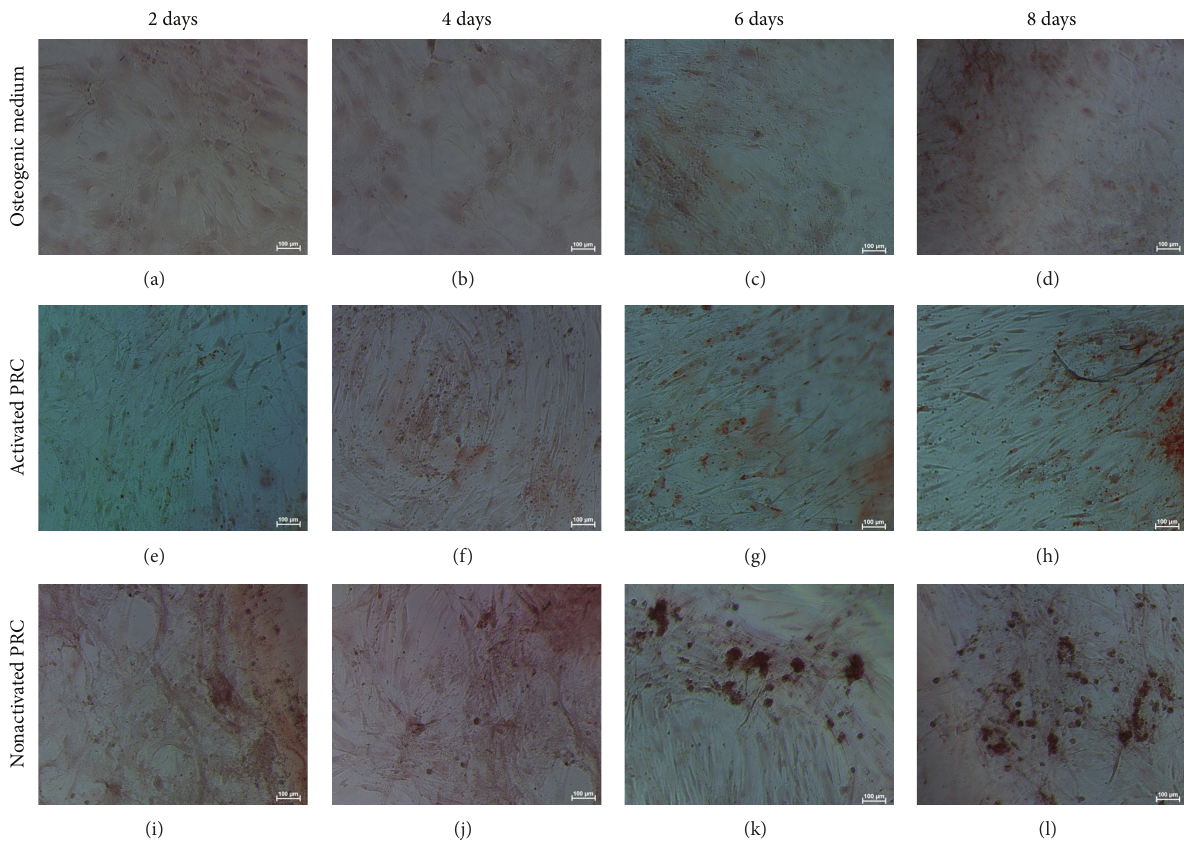
Figure 8: Cells stained with Alizarin Red. Cells cultured in osteogenic medium (a)–(d), activated PRC (e)–(h), and nonactivated PRC (i)–(l). Cells cultured in PRC were fixed with formalin after each time point and were stained with Alizarin Red. Cells cultured in osteogenic medium served as the positive